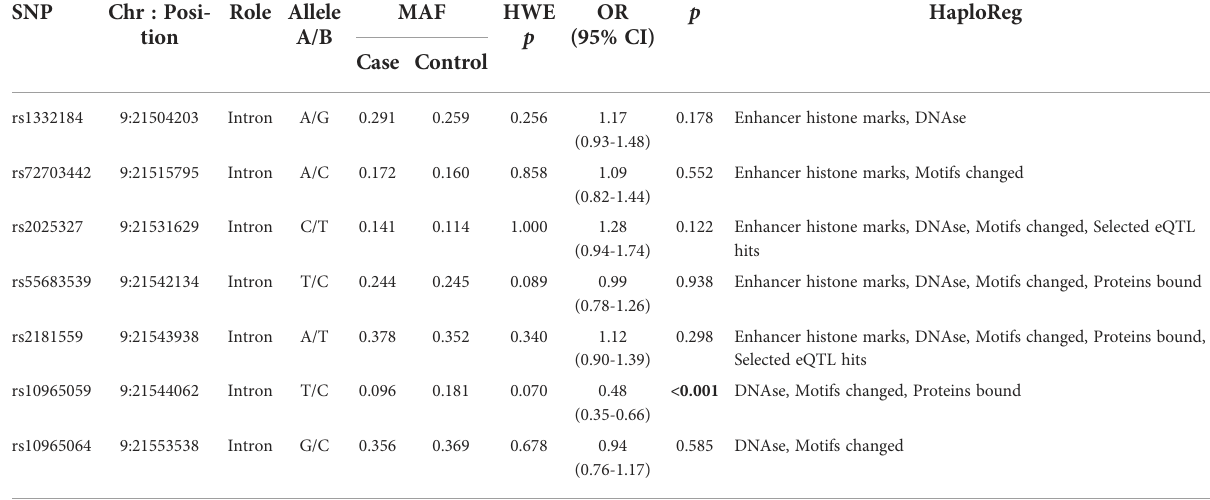
TABLE 2 Basic information of the selected SNPs in